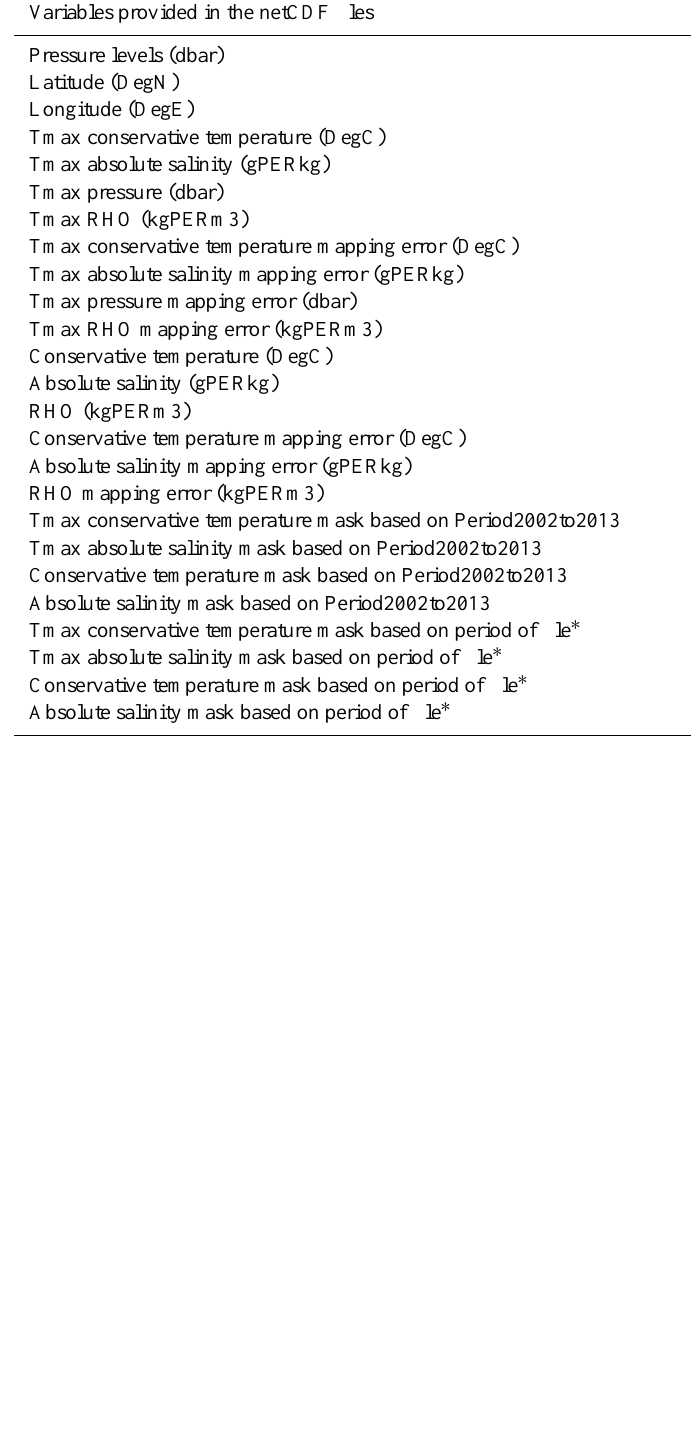
Table A2. List of variable names in the accompanying netCDF file. The mapped variables listed are provided in the form of grids structured by latitude × longitude × pressure level, where fill values are NaNs. The asterisk ( ∗ ) indicates variables which are not found in the